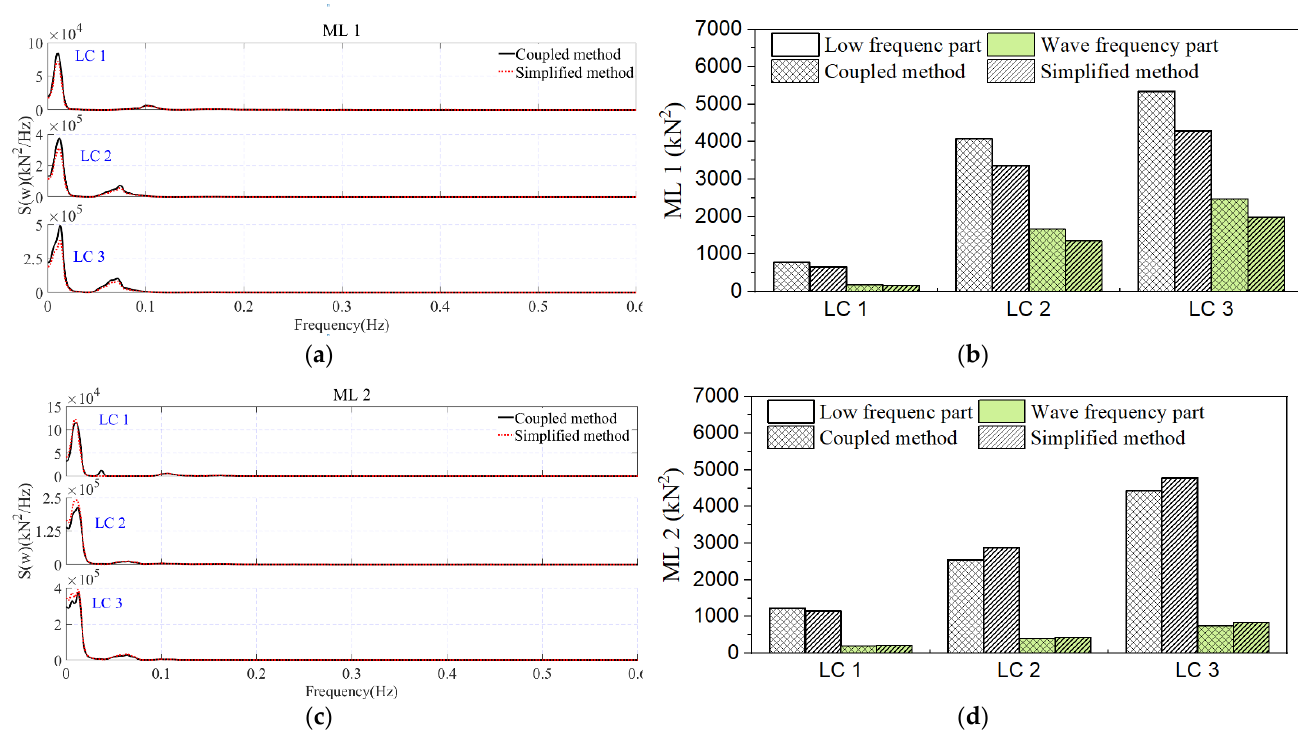
Figure 14. PSD plot of mooring line tension for WindFloat SFOWT platform under different load cases: ( a ) ML 1 tension; ( b ) Integrals of ML 1 tension; ( c ) ML 2 tension; ( d ) Integrals of ML 2 tension.